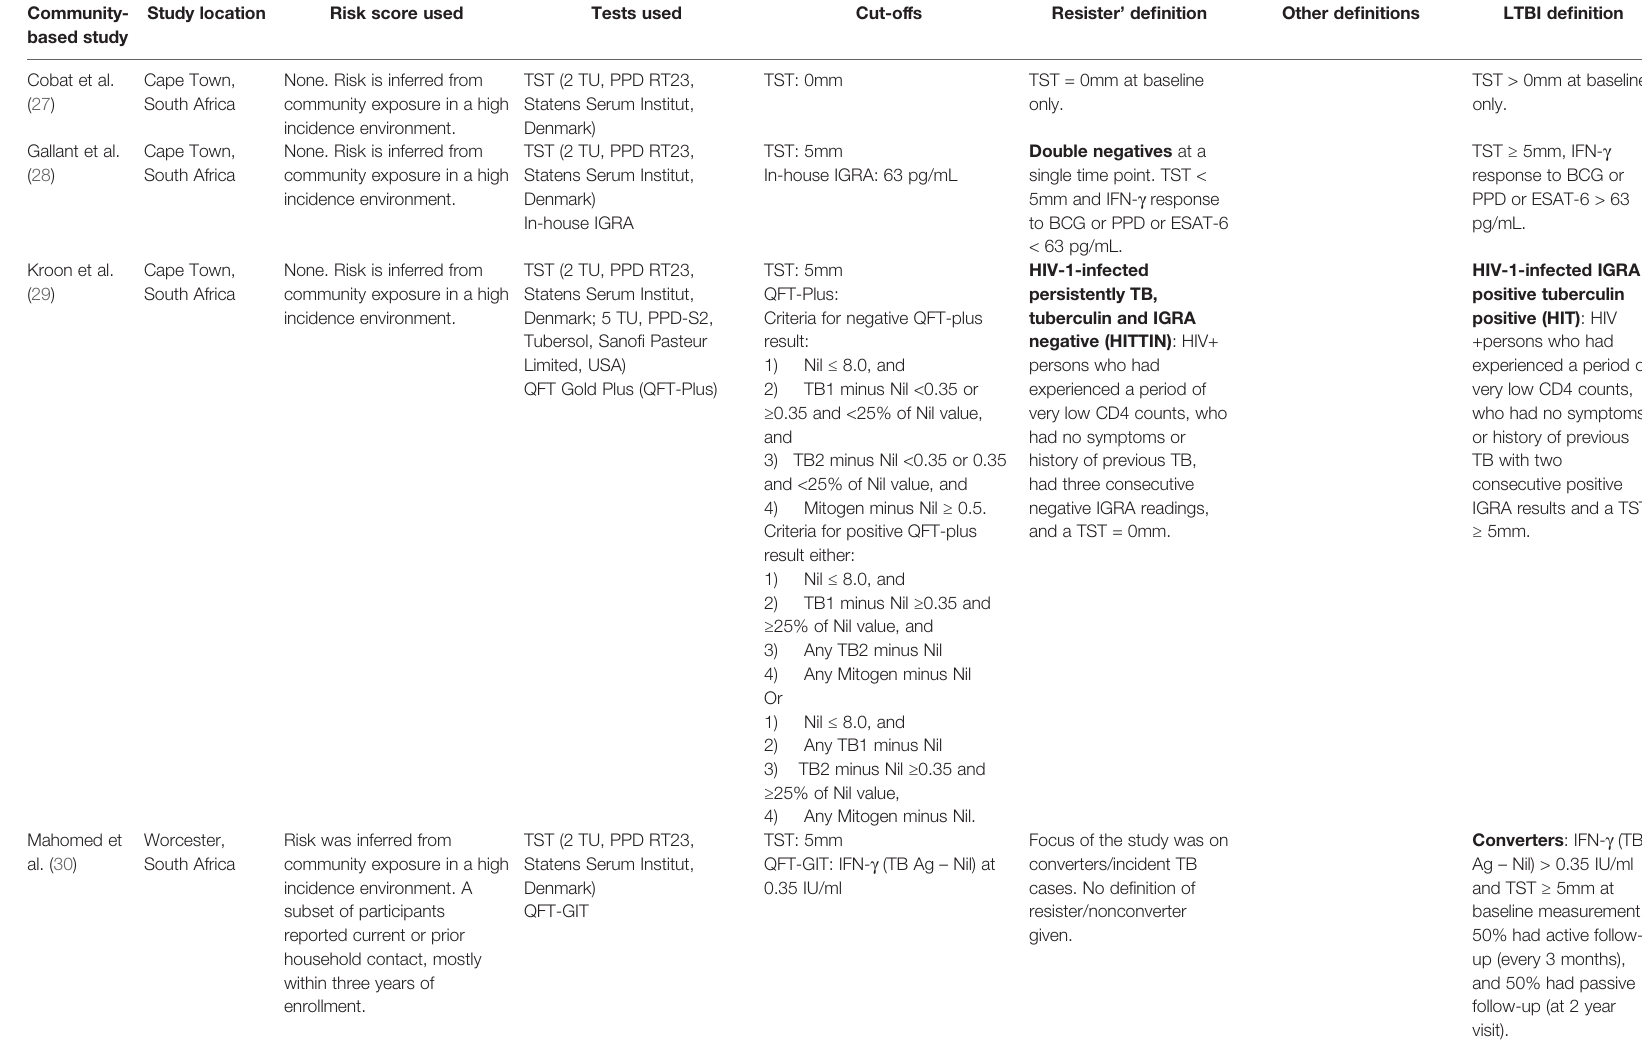
TABLE 2 | Summary of tests and de fi nitions used by community-based